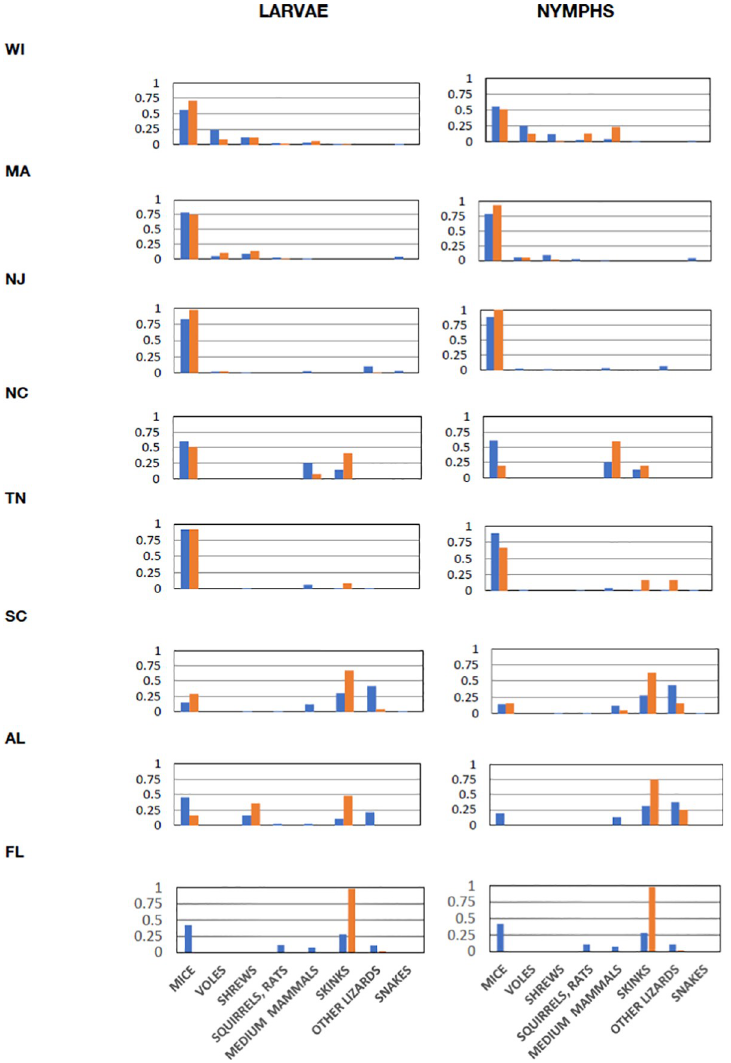
Fig 3. Proportions of hosts of different categories in samples and proportions of ticks collected from hosts in each category. Blue bars are proportions of hosts in each category, and orange bars are proportions of ticks collected from hosts in each category. Taxa in each category: mice ( Peromyscus and Ochrotomys ), voles ( Myodes and Microtus ), shrews ( Sorex and Blarina ), squirrels, rats ( Tamias , Glaucomys , Tamiasciurus , Neotoma , and Oryzomys ), medium mammals ( Procyon and Didelphis ), skinks ( Plestiodon and Scincella ), other lizards ( Sceloporus and Anolis ), and snakes ( Diadophis , Storeria , Thamnophis , and Coluber ). Data combined from 2011 and 2012 (when all 8 sites were sampled). Data are available in S5 Data (raw data in S3